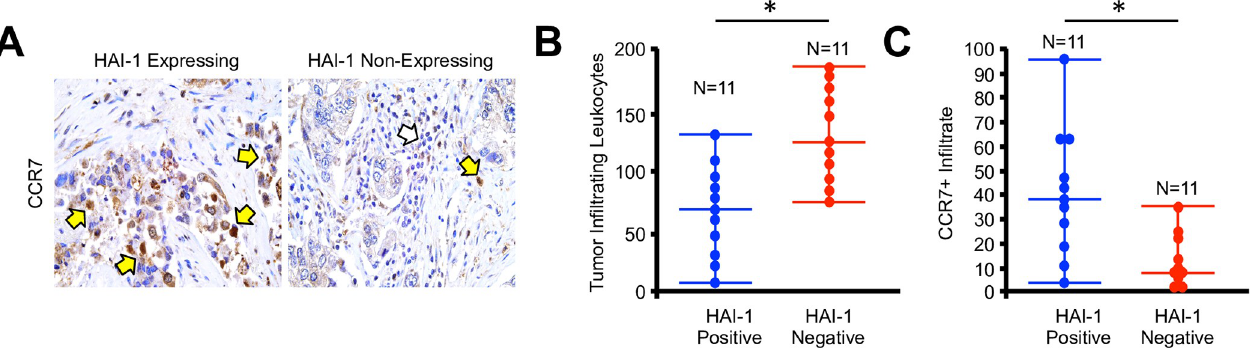
Fig 4. Loss of HAI-1 is associated with reduced M1-macrophage infiltration in microarray lung cancer specimens. (A) NSCLC specimens were stained for expression of the M1 macrophage surrogate CCR7, and representative images shown for HAI-1 expressing and HAI-1 non-expressing tissues. (B) The number of tissue infiltrating leukocytes per high power field was quantified and arranged by HAI-1 status. (C) CCR7 positive macrophages were quantified per high power field and arranged by HAI-1 status. ( � p < 0.05).